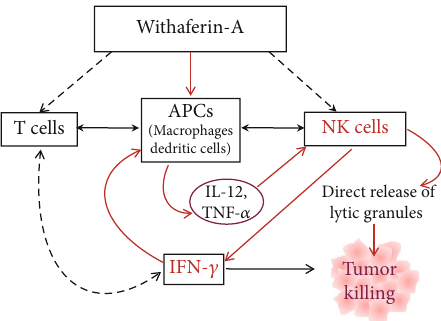
Figure 3: WFA triggers immunostimulatory cascade associated with NK cell regulation and antitumor